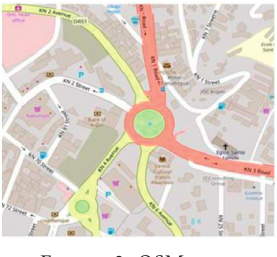
Figure 2: OSM map.